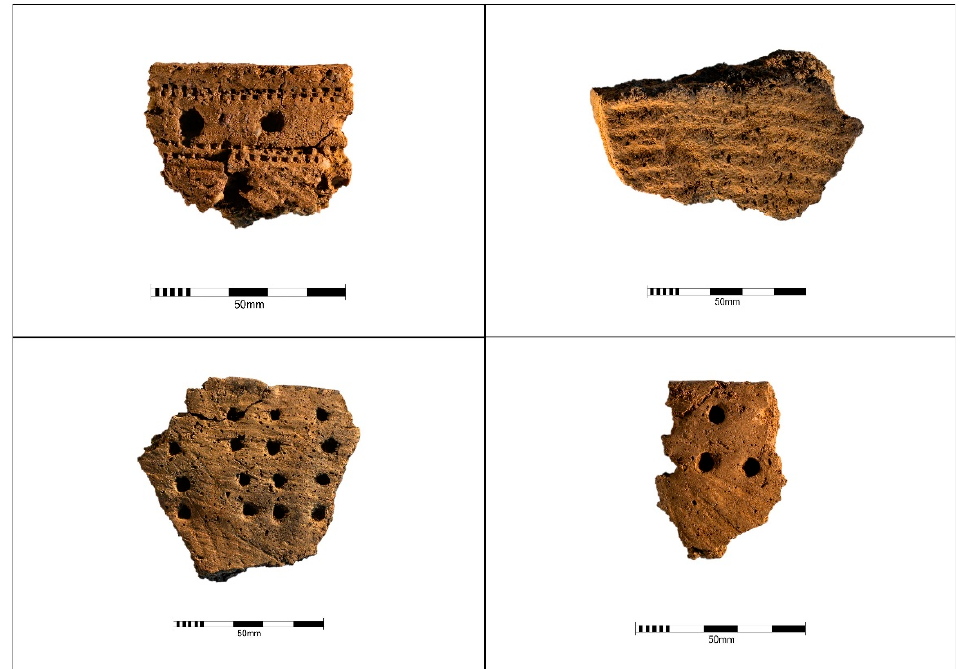
Figure 2. Kiukainen pottery, photo by Marjo Karppanen. Upper right bottom of a vessel with tex- tile imprints; the rest are rim sherds. imprints; the rest are rim